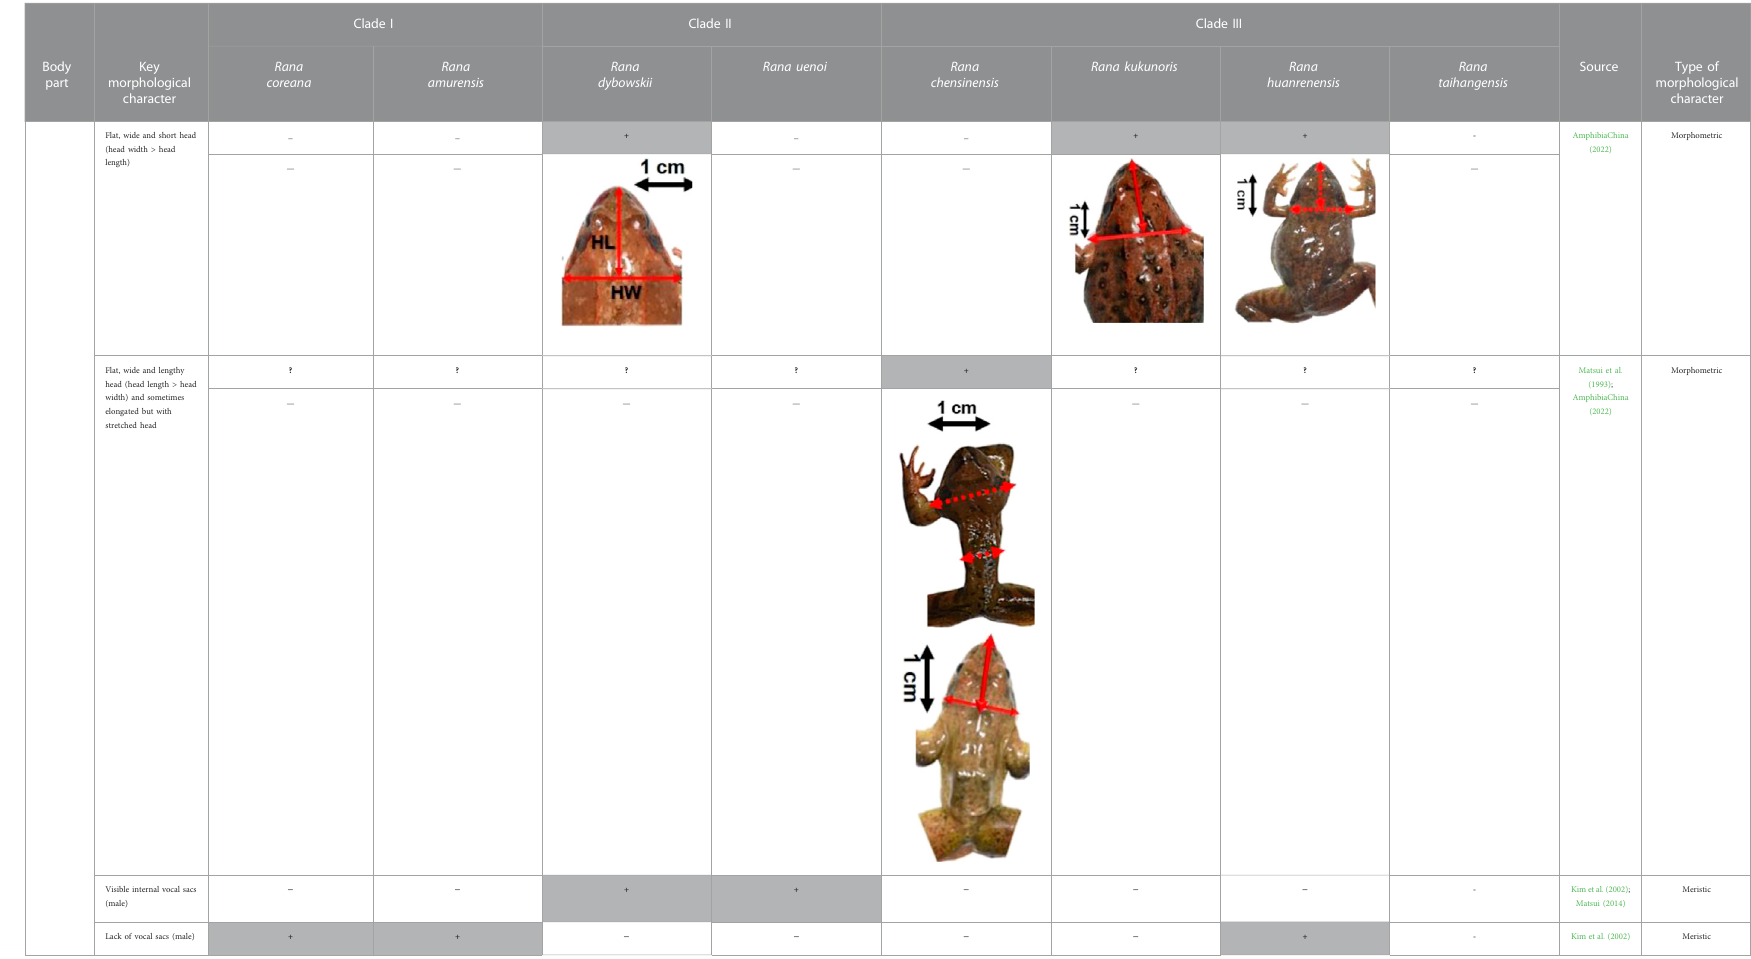
TABLE1( Continued )Identi fi cationkeyandcomparisonof40morphological charactersbetweeneightspeciesofnortheasternAsianbrownfrogs(genus Rana )recordedfromtheliteraturesandonlinedatabasesofamphibians: AmphibiaWeb (https://amphibiaweb.org)andAmphibiaChina (https://www.amphibiachina.org/).Theboxescolouredingreyandmarkedwithsymbol(+)indicatethepresenceofthecharacterinthespeciesandthecolourless boxes marked with symbol ( − ) indicate the absence of the character in the species, OR, the absence of de fi nitive information but matching with at least a few individuals of the species. The symbol (?) indicate the lack of information about the speci fi c morphological character. Coloration outside of the breeding season is not speci fi ed as the trade is limited to the breeding season when body condition makes frogs more suitable for human consumption. The comparison of morphological characters and classi fi cations of Rana into clades I, II and III in the table are adapted from the operational taxonomic units (OTU) based on the 16S rRNA phylogeny of Othman et al. (2022), where R. chensinensis matches with OTU 7 and R. taihangensis matches with OTU 1 and 2, following Shen et al.